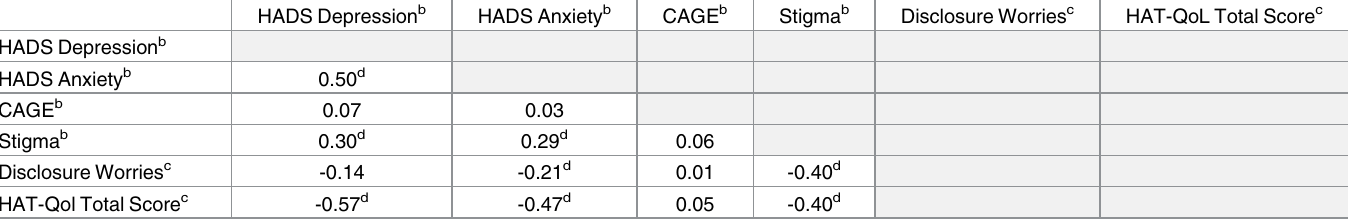
Table 3. Correlations a between mental health indicators.